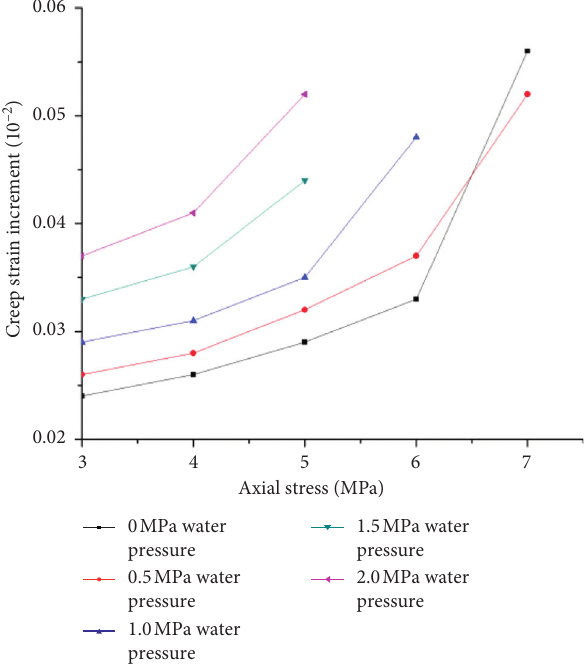
Figure 14: Creep increment–axial stress curve under different water pressures.